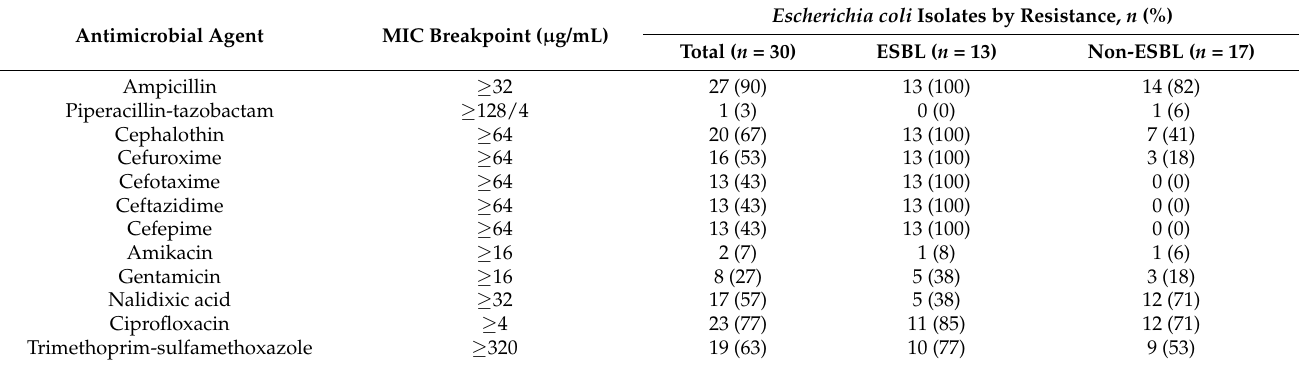
Figure 1. Distribution of ESBL-producing versus non-producing E. coli strains according to patient type. ESBL: extended-spectrum β -lactamase. Table 1. Antimicrobial resistance of Escherichia coli isolates.